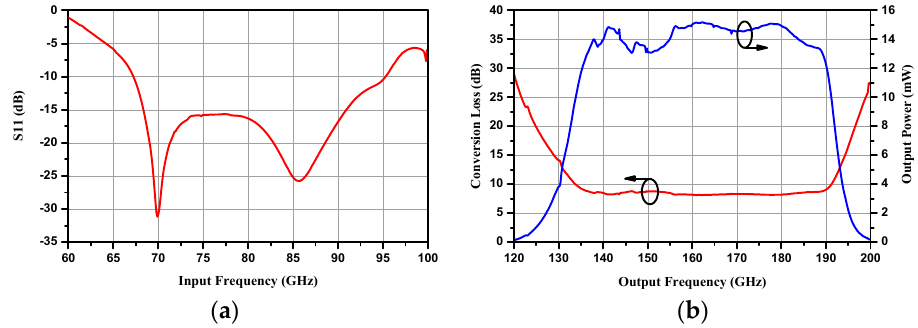
Figure 8. Simulated input return loss, conversion loss and output power with 100 mW input power under a 100 Ω self-bias resistor.